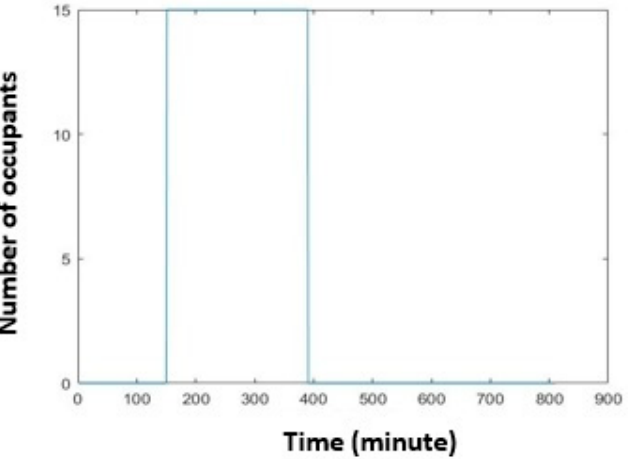
Figure 14. Occupancy versus time in 12 h of experimentation in a practical classroom with a large size.